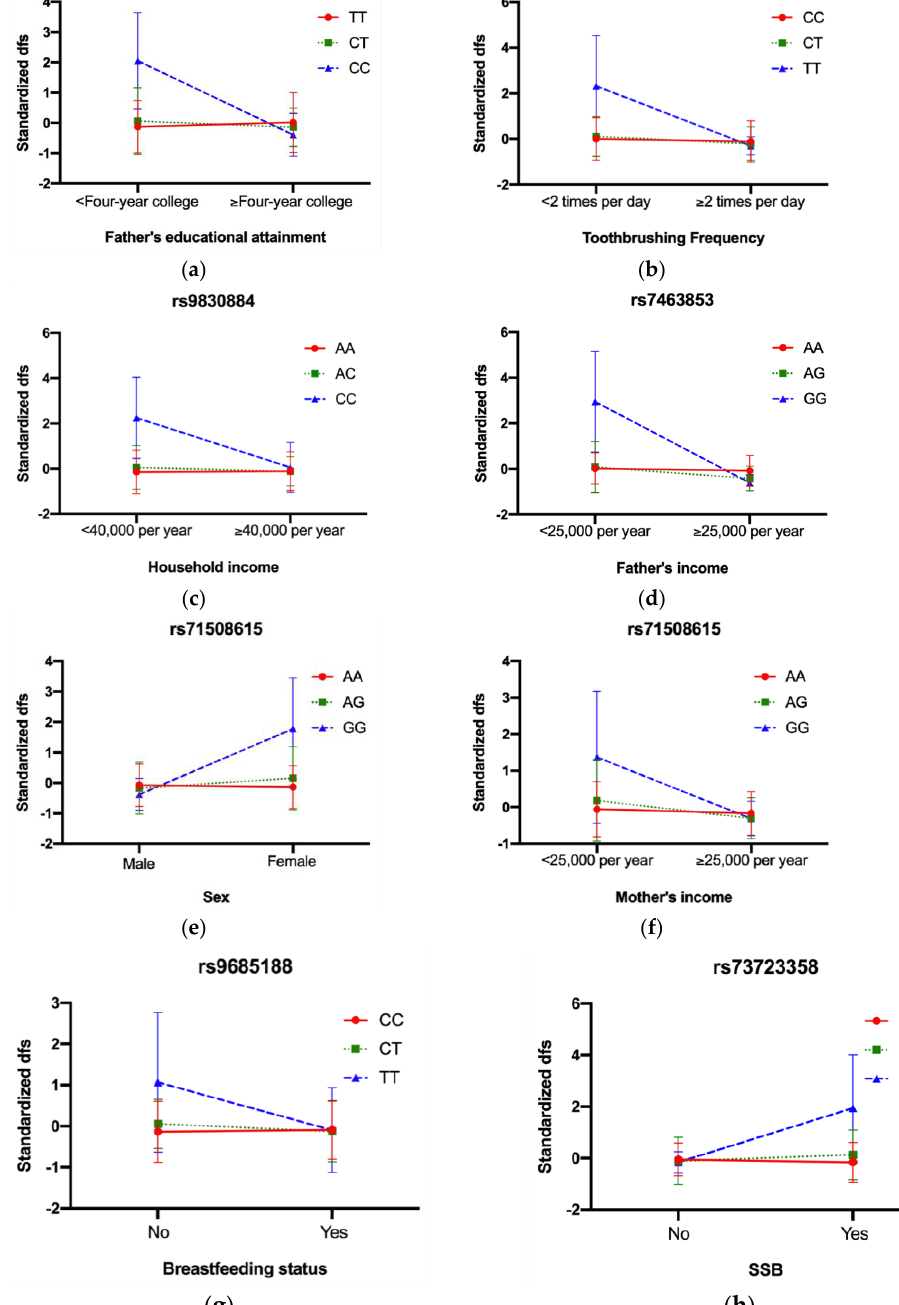
Figure 3. Interaction plots for significant GEI across three cohorts. In IFS, ( a ) rs1491071 with fa- Interaction plots for significant GEI across three cohorts. In IFS, ( a ) ther’s educational attainment, CC genotype had higher dfs when father’s educational attainment < Four − year college; ( b ) rs1978471 with toothbrushing frequency, TT genotype had higher dfs when toothbrushing frequency < 2 times per day; ( c ) rs9830884 with household income, CC genotype had higher dfs when household income < 40,000 per year; In COHRA1, ( d ) rs7463853 with father’s income, GG genotype had higher dfs when father’s income < 25,000 per year; In COHRA2, ( e ) rs71508615 with sex, GG genotype had higher dfs when sex was female; ( f ) rs71508615 with mother’s income, GG genotype had higher dfs when mother’s income < 25,000 per year; ( g ) rs9685188 with breastfeeding status, TT genotype had higher dfs when breastfed; ( h ) rs73723358 with SSB, GG genotype had higher dfs when intaking SSB.